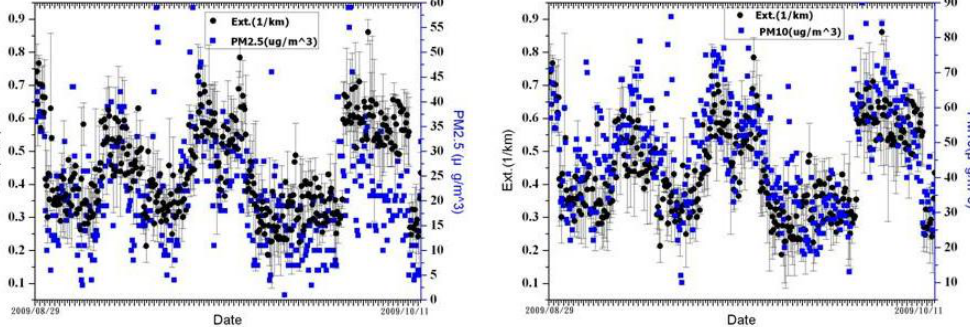
Figure 6. Comparison of (a) PM 2 . 5 and (b) PM 10 concentrations with the aerosol extinction coefficient derived from the scanning lidar at 532nm. The measurements were taken over the Guanyin industrial area during the period from 29 August to 11 October 2009. The PM data are hourly averages; while the lidar data are shown for every 1min. Error bars indicate the standard deviation of aerosol extinction coefficient.